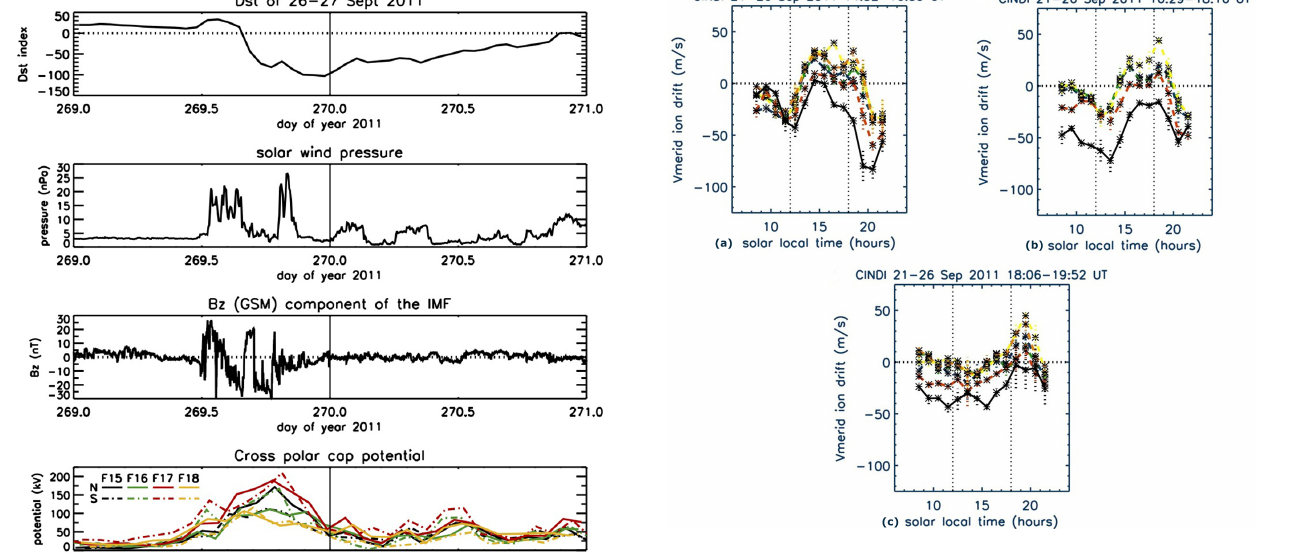
Figure 5. These three plots show the meridional flows for the first three dayside passes after the storm onset on 26 September (plotted in black) compared to the same flows seen at the same times of day on the previous five quiet days (plotted in colors). Although the magnitude varies from pass to pass and for different local times, it is clear that all the meridional flows in these passes after the storm onset show an excess downward velocity relative to the baseline quiet day flows. The storm day passes in these figures cover 15:44 to 16:39UT (first pass), 17:21 to 18:16UT (second pass) and 18:57 to 19:52UT (third